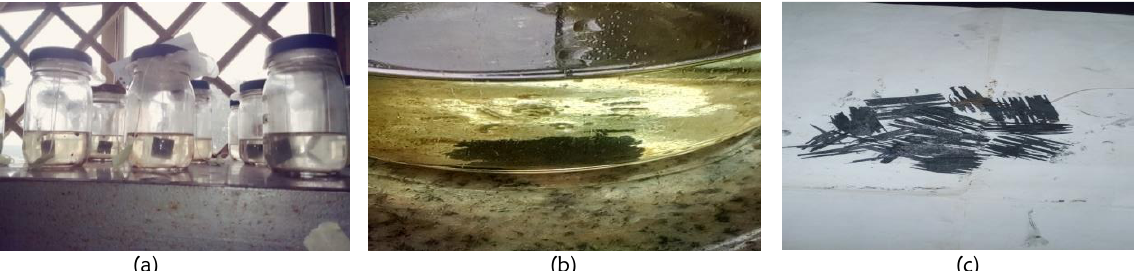
Figure 8: Effectiveness of Prosopis Africana as an inhibitor in HCl medium. (a) Nature of the low carbon steel immediately (b) The low carbon steel totally destructed after 168 hours after immersion without inhibitor of exposure in the medium without inhibitor due to aggressiveness of the evironment (c) Nature of the low carbon steel without inhibitor in HCl after corrosion